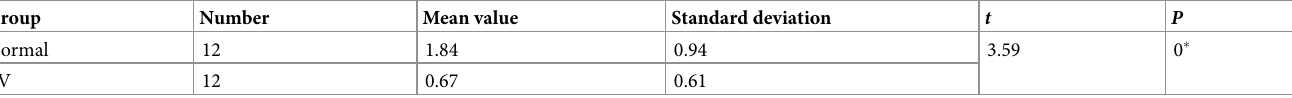
Table 3. Western blot detection of the relative protein level of GSDMB in skin tissue. Group